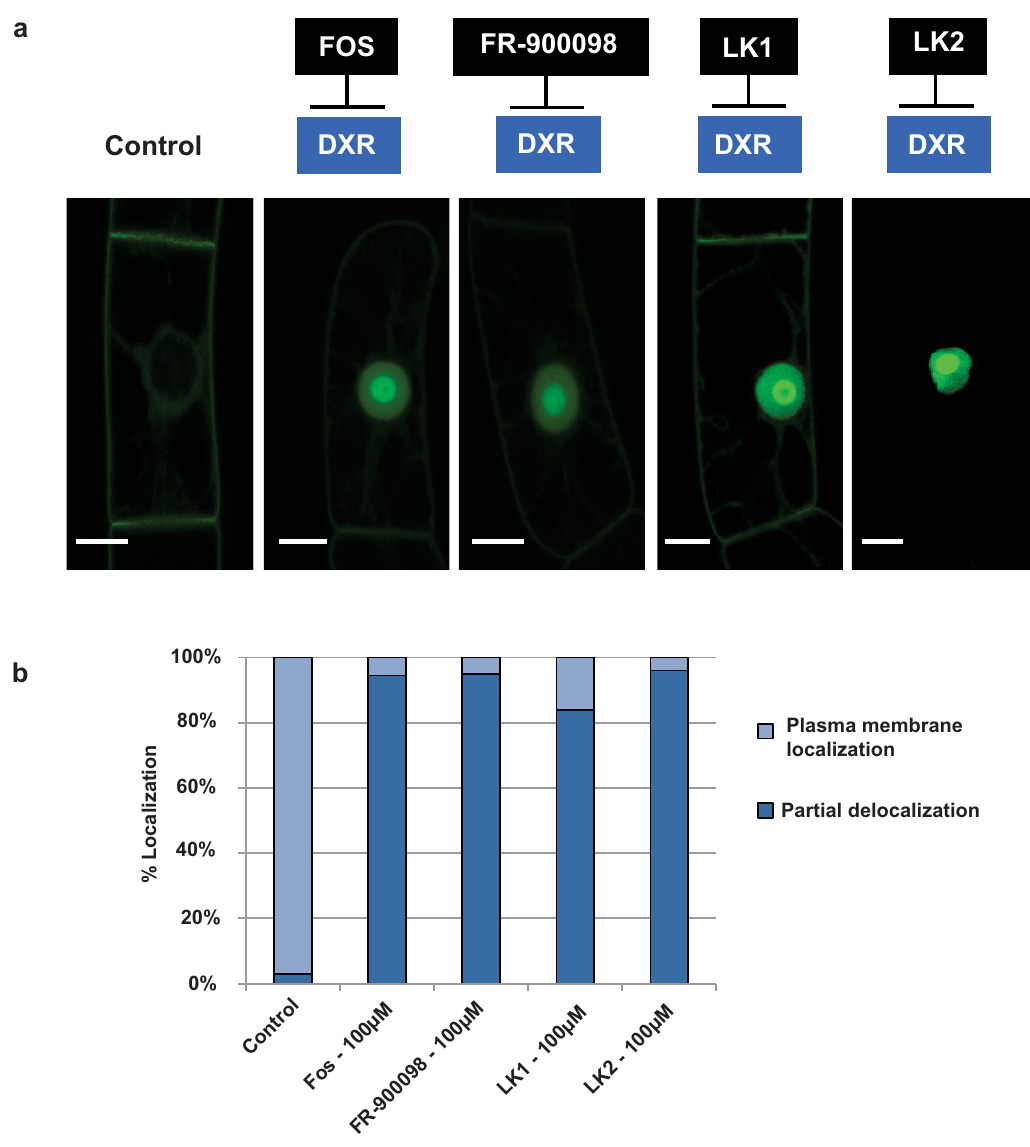
Figure 5. Localization of H -GFP-BD-CVIL in transformed BY-2 cells after treatment with different inhibitors of DXR. a ) Confocal images 6 were taken after treatment with different inhibitors of DXR, under standard conditions (3 h pretreatment, followed by 15 h induction with 10µM dexamethasone). Control: Cells were treated with the same volume of solvent (DMSO). Inhibitors: All inhibitors (Fosmidomycin = FOS, FR-900098, LK1 and LK2) were tested at 100µM and caused a significant translocation of the GFP fusion protein to the nucleus/nucleolus. White bars = 10µm. b ) Quantitative analysis of H -GFP-BD-CVIL localization in BY-2 cells treated with inhibitors of DXR. Percentage of cells 6 showing a partial localization of the fluorescence to the nucleus and nucleolus (without taking care of the total intensity of this translocation) and the plasma membrane. For each treatment more than 100 individual cells were